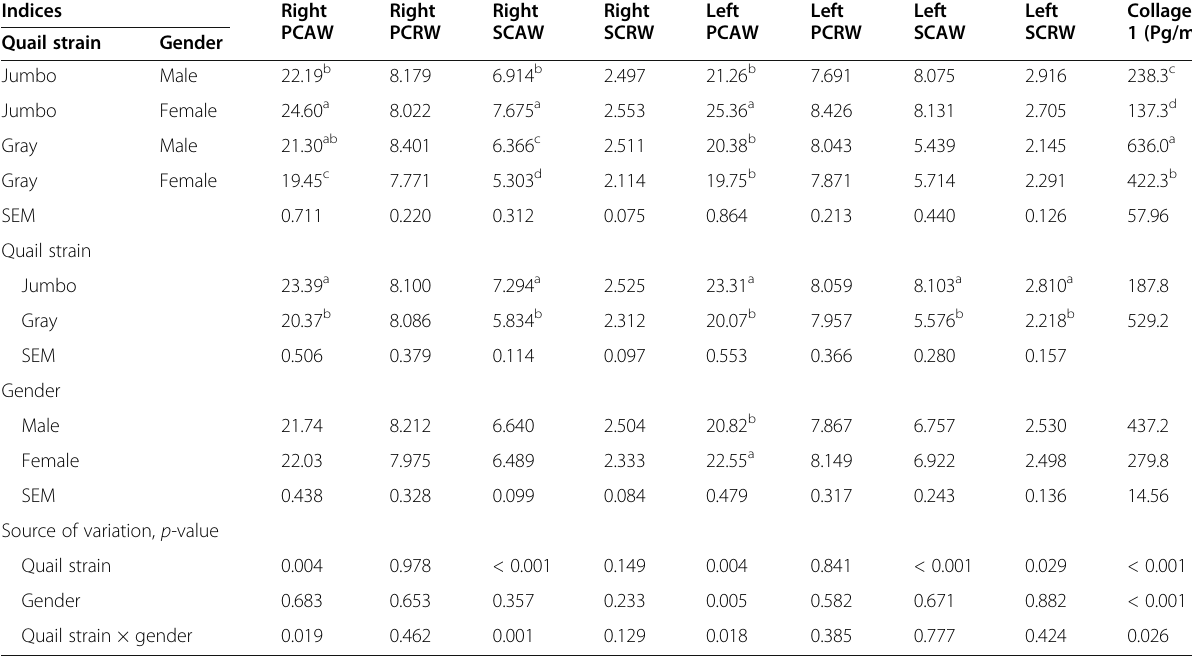
Table 4 Differences in collagen type 1 concentration in breast tissue and absolute weight (AW), relative weight (RW) of pectoralis (PC), and supracoracoideus (SC) muscles in jumbo and gray Japanese quail strains Indices